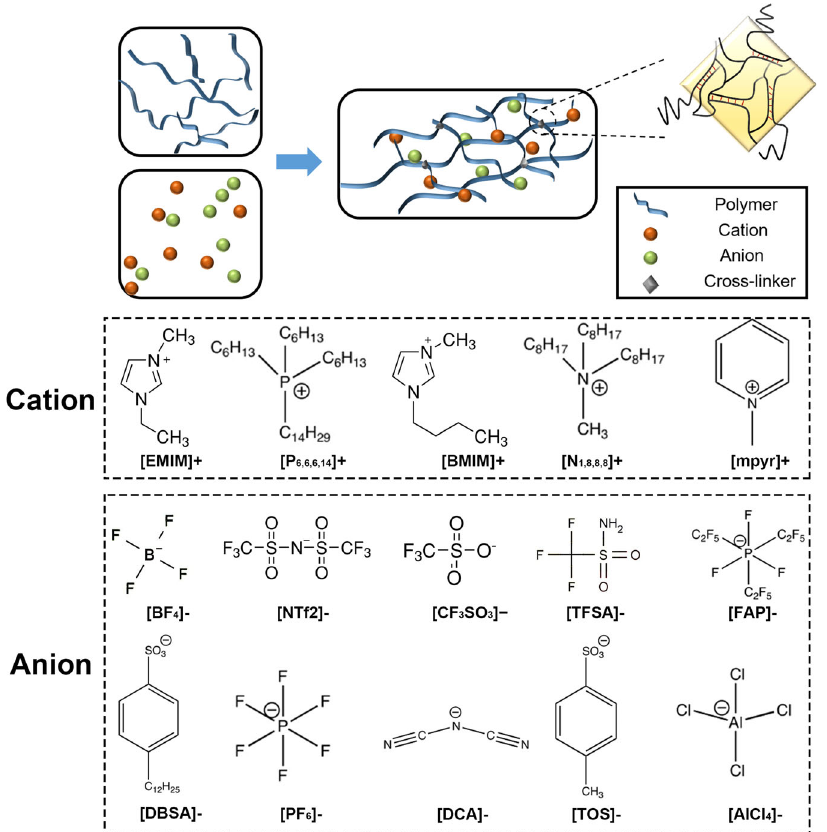
Fig. 2 The type of ionic-gel structure. Three different types of ionic-gel composition structure and main ionic-gel anion and cation